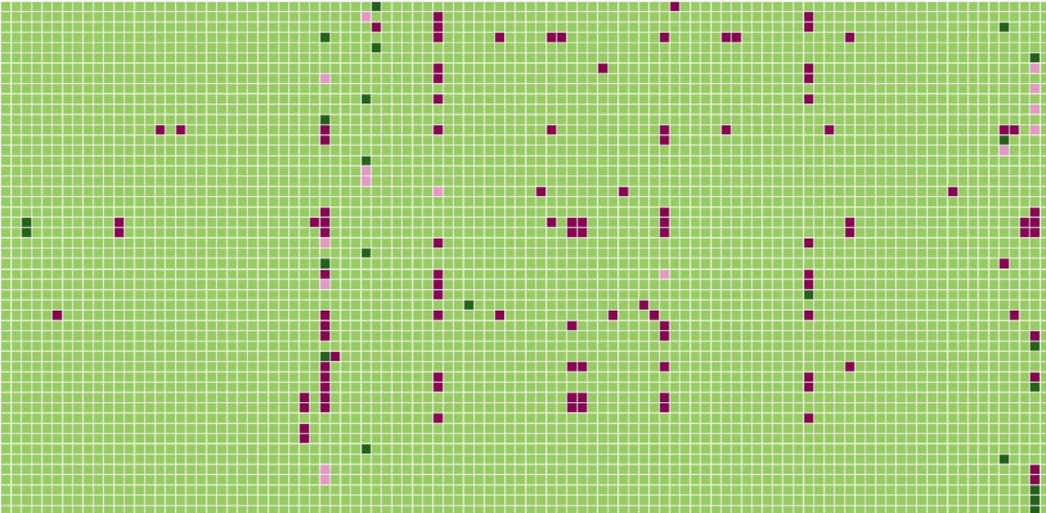
Figure 7. Heatmap representation of the performance prediction with the GCN model for a subset of the compound-olfactory receptors (ORs) associations. The ORs are represented on the X-axis and the compounds on the Y axis. A compound associated to an OR and correctly classified by the GCN model is colored with a dark green cell. A compound not associated to an OR and correctly predicted has a light green color. A compound linked to an OR and wrongly predicted by the model is represented in a pink color and a compound not linked to an OR and predicted to be associated to this odor is shown with a red color. The heatmap was developed with the python package seaborn (v.0.11.2): https:// seabo rn. pydata. org/ 63,64